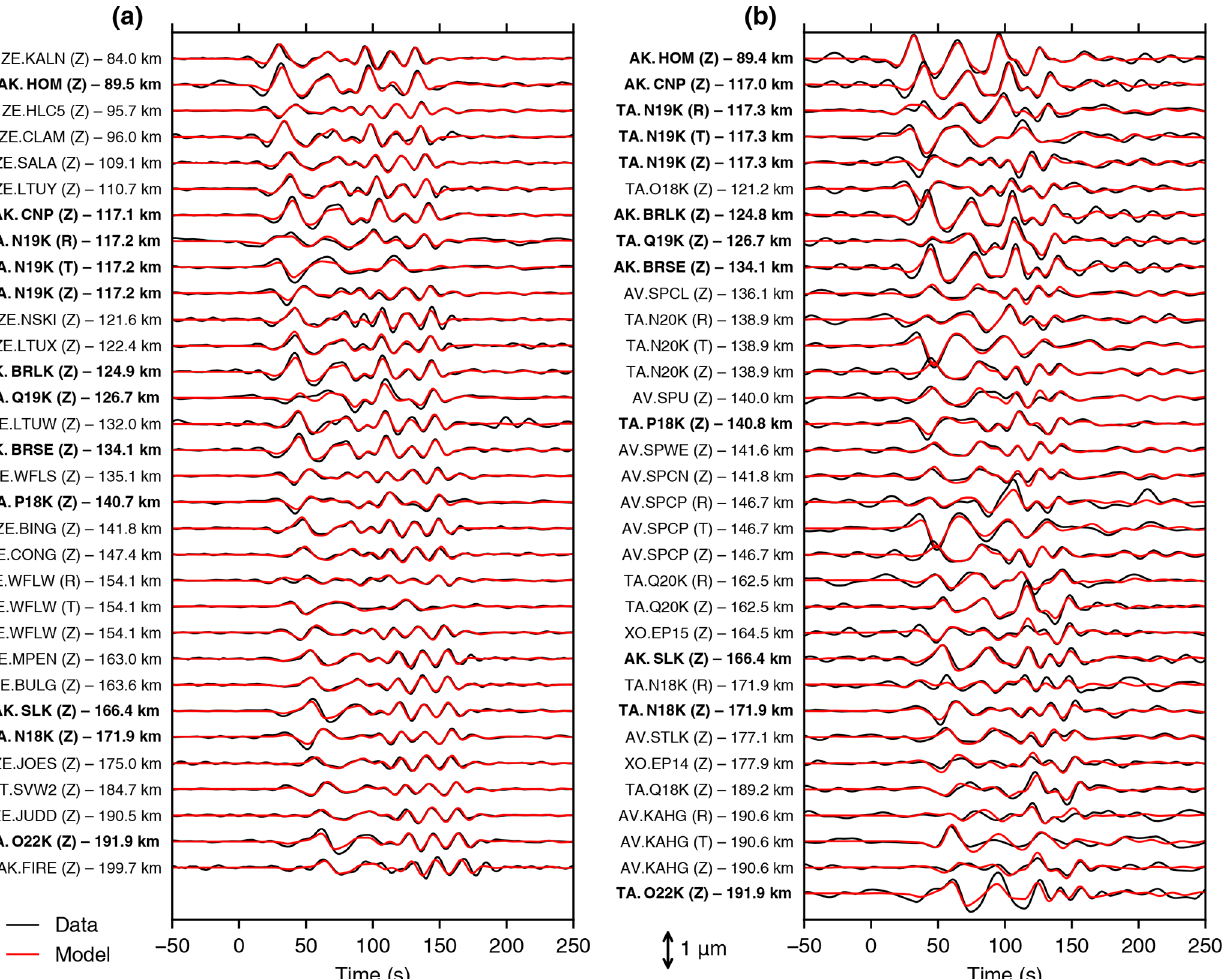
Figure 9. Waveform fits for the (a) 2016 and (b) 2019 force inversions. Observed data are plotted as black lines; modeled data are shown as red lines. Letters in parentheses indicate vertical (Z), radial (R), and transverse (T) components, and distance to the point force location is noted for each waveform. Boldface labels indicate components of stations used in both inversions (see Fig. 1). Waveforms are not individually normalized, and the amplitude scale is identical between (a) and (b) . The time axes are relative to the inversion zero time. (See Sect. 3 for description of network